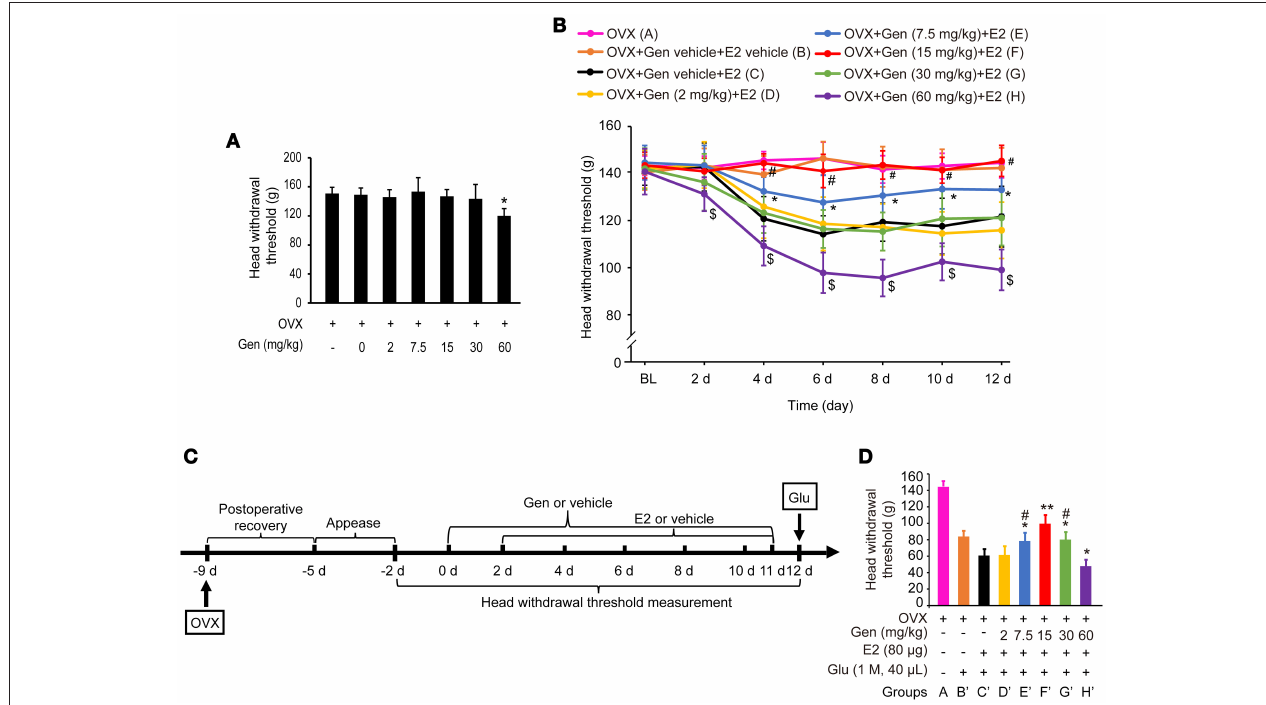
FIGURE 3 | Dose-dependent differential effects of genistein on masseter muscle hypernociception. (A) The effects of genistein alone on masseter muscle mechanical hypernociception. * P < 0.05 compared to all other groups. (B) The effects of genistein on E2-induced masseter muscle hypernociception. * P < 0.05, comparison between group E and group C; # P < 0.05, comparison between group F and group C; $ P < 0.05, comparison between group H and group C. (C) Schematic graph of genistein effects on E2 and glutamate-evoked masseter muscle hypernociception. From day 0, group B and C received genistein vehicle, and group D, E, F, G, and H received their respective doses of genistein daily for 12 days. From day 2, genistein or its vehicle was injected 2h earlier for the related groups, and then group B received E2 vehicle and group C, D, E, F, G, and H received 80 µ g E2 for 10 days. On day 12, animals in all groups except group A received glutamate injections